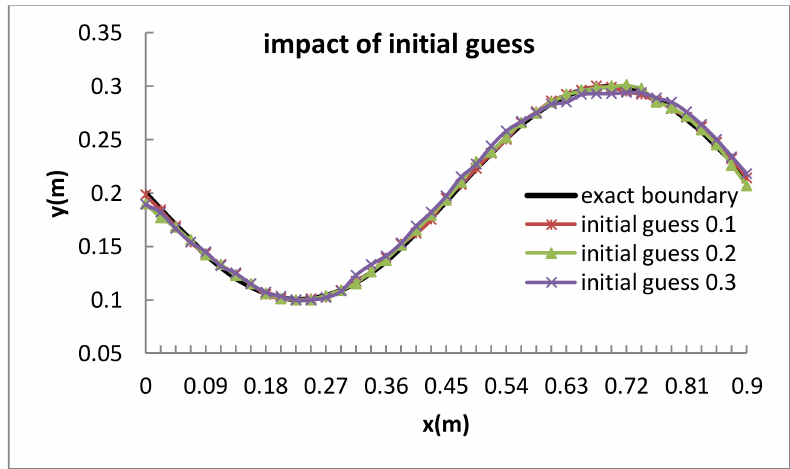
Figure 4. Identification results of di ff erent initial guess boundaries of case 1.